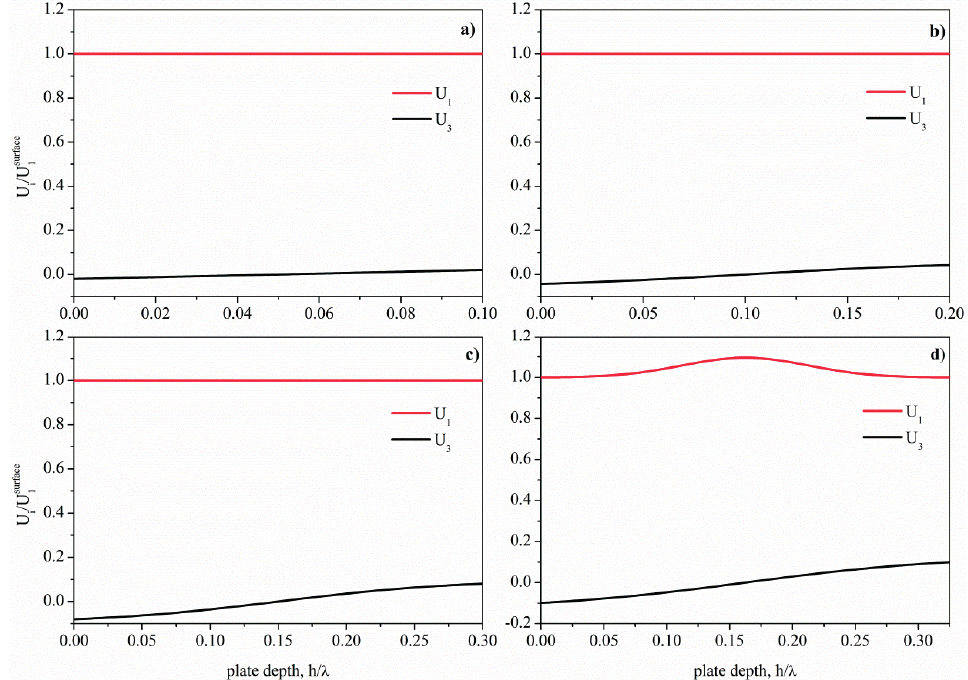
Figure 2. Depth profile of the AMs propagating along BN plates of different thicknesses normalized to the wavelength: ( a ) h BN / λ = 0.1; ( b ) h BN / λ = 0.2; ( c ) h BN / λ = 0.3; and ( d ) h BN / λ =